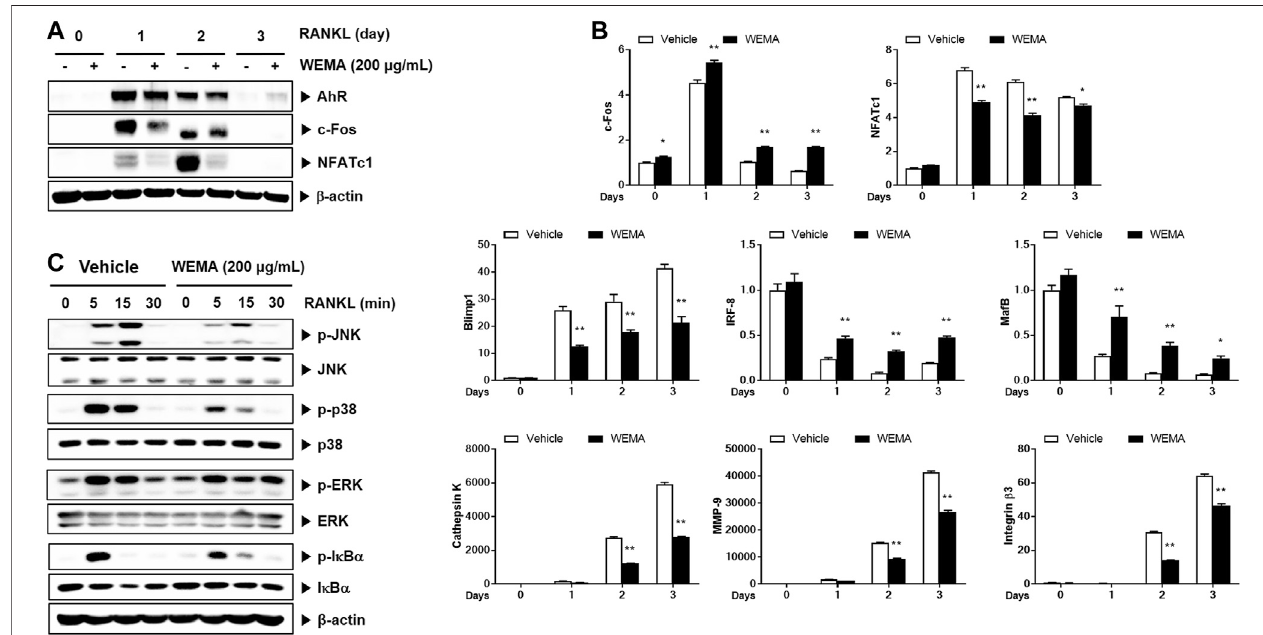
FIGURE2| WEMA inhibits RANK-inducedsignaling requiredfor NFATc1 induction. (A,B) BMMs werepre-treated withorwithout WEMA(200 μ g/ml)for3 h inthe presence ofM-CSF (60 μ g/ml). Then, the cellswerestimulated with RANKL (50 ng/ml) for0, 1,2, or 3 days. (A) The protein expression ofAhR, c-Fos,and NFATc1 was analyzed by western blot. (B) The mRNA expression of c-Fos, NFATc1, Blimp1, IRF-8, MafB, cathepsin K, MMP-9, and integrin β 3 was analyzed by qPCR. (C) BMMs werepre-treatedwithorwithoutWEMA(200 μ g/ml)for3 hinthepresenceofM-CSF(60 μ g/ml).ThenthecellswerestimulatedwithRANKL(50 ng/ml)for0,5,15, or30 min.Theindicatedproteinswereanalyzedbywesternblot.Valuesarethemean ± SDofonerepresentativeexperimentoutofthreewithsimilarresults,performedin triplicates. * p < 0.05, ** p < 0.01 versus control.